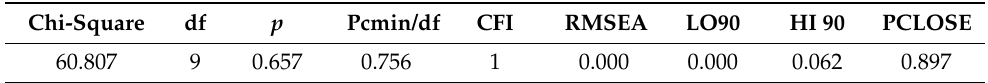
Figure 2. CFA of PIS (regression weights)—study 2. Source: own elaboration. Similar to study 1, high correlations of the test items with the latent variable, prayer importance were observed. Fit indices confirmed good model fit to the data (see Table 4). Table 4. Fit indices of the model in study